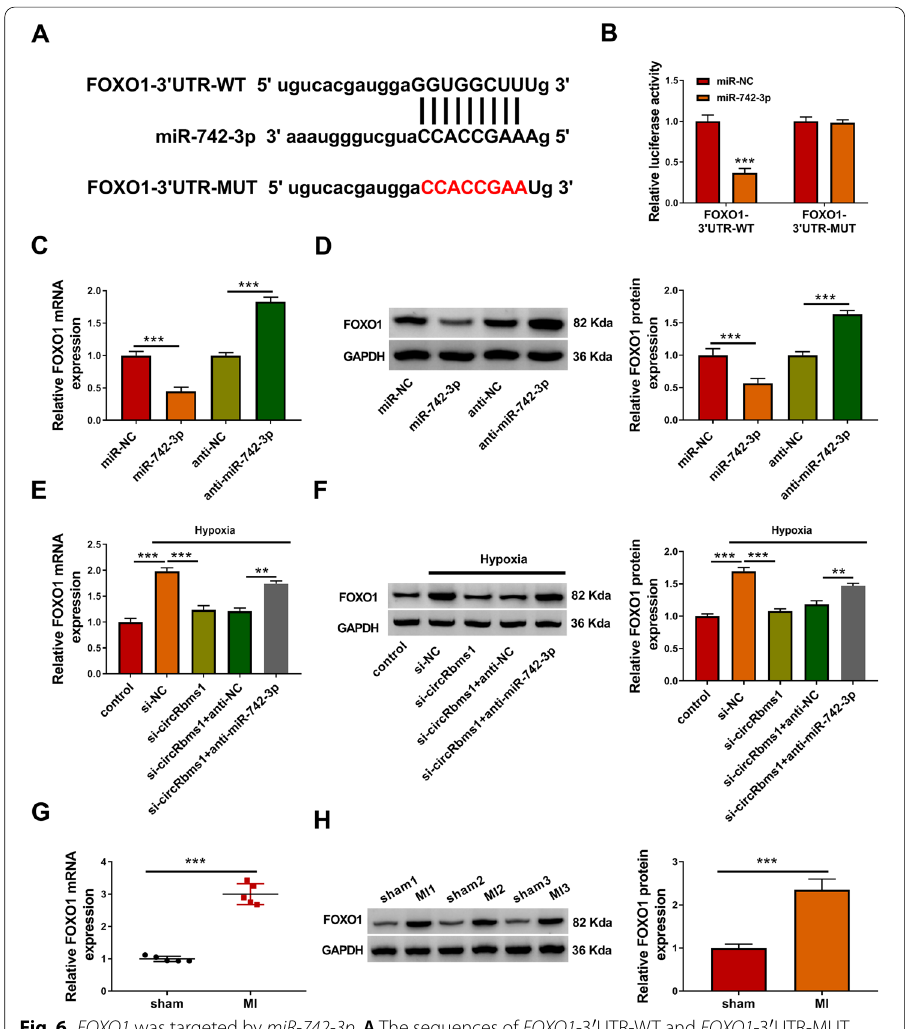
Fig. 6 FOXO1 was targeted by miR-742-3p . A The sequences of FOXO1 -3 ′ UTR-WT and FOXO1 -3 ′ UTR-MUT. B Dual-luciferase reporter assay was used to confirm the interaction between miR-742-3p and FOXO1 . C , D H9c2 cells were transfected with miR-NC (50 nM), miR-742-3p (50 nM), anti-NC (50 nM), or anti- miR-742-3p (50 nM). The mRNA and protein expression levels of FOXO1 were measured using qRT-PCR and WB analysis. E , F H9c2 cells were transfected with si-NC (50 nM), si- circRbms1 (50 nM), si- circRbms1 (50 nM) anti-NC (50 nM), + or si- circRbms1 (50 nM) anti- miR-742-3p (50 nM), and then treated with hypoxia. Untreated H9c2 cells were + used as control. qRT-PCR and WB analysis were used to determine the mRNA and protein expression levels of FOXO1. G – H The mRNA and protein expression levels of FOXO1 in the heart tissues of sham mice and MI mice were examined using qRT-PCR ( n 6 per group) and WB analysis ( n 3 per group). All experiments = = were repeated three times. ** P < 0.01, *** P <